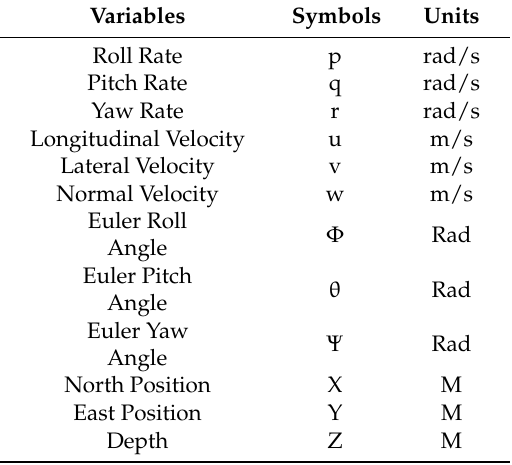
Table 1. State Variables.